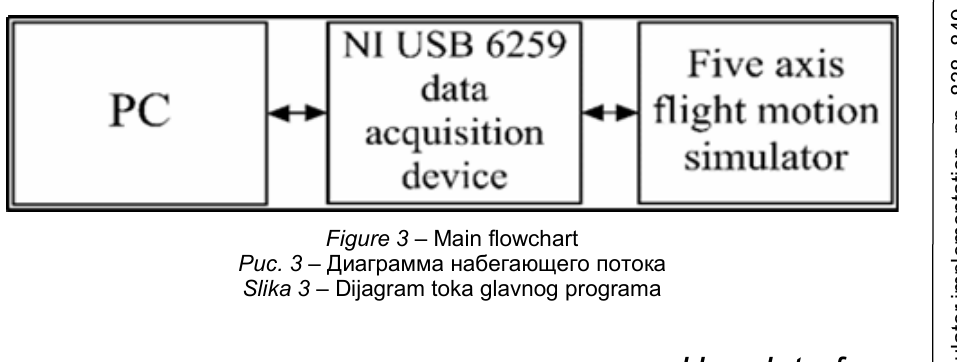
Figure 3 – Main flowchart Рис . 3 – Диаграмма набегающего потока Slika 3 – Dijagram toka glavnog